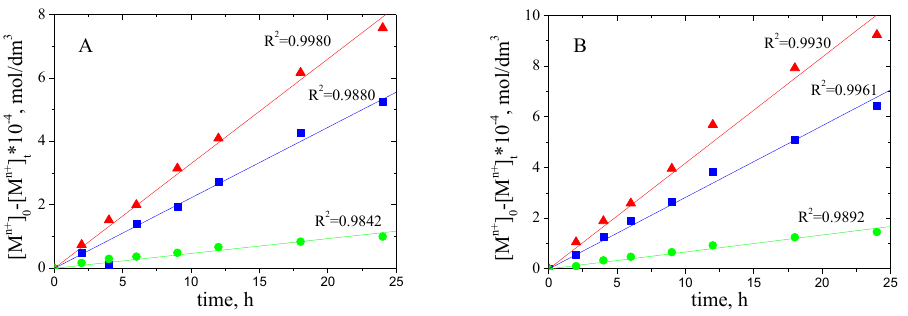
Figure 5. Dependence [M 2+ ] 0- [M 2+ ] t vs. time for ▲ -Pd (II), ◼ -Zn (II), and ● -Ni (II) ions transport across PIMs with 1-pentyl-triazole ( A ) and 1-hexadecyl-triazole ( B ).